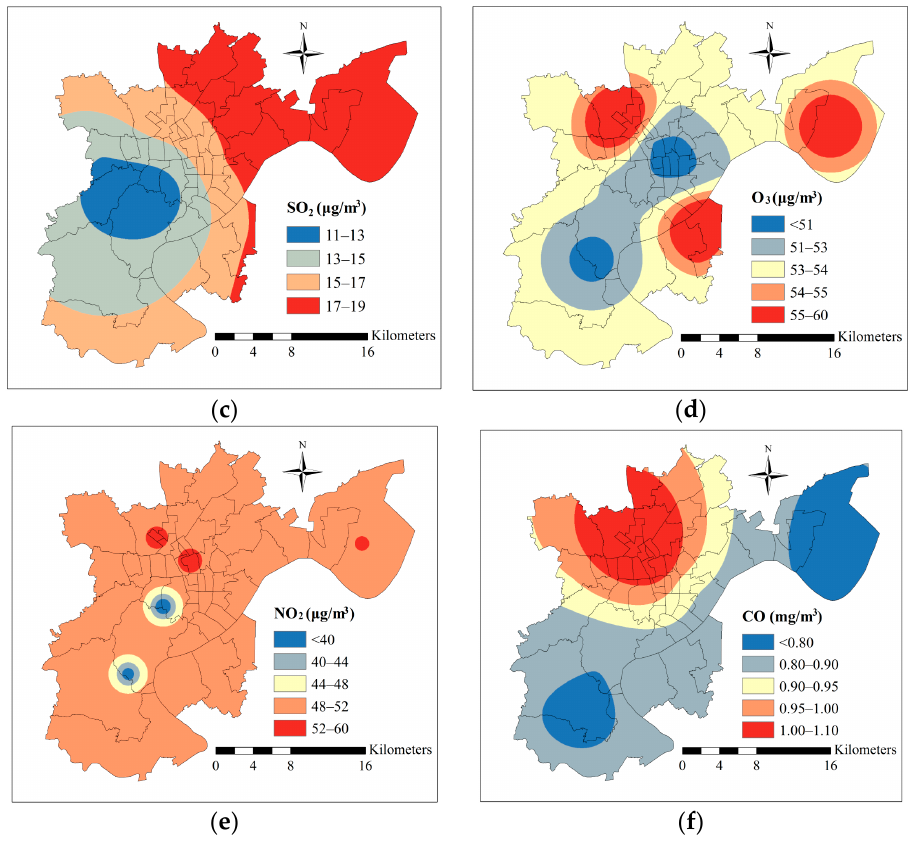
Figure 12. Spatial distribution of annual average concentrations of particulate matter and trace gases in Hangzhou City for 2015: ( a ) PM 2.5 ( μ g/m 3 ); ( b ) PM 10 ( μ g/m 3 ); ( c ) SO 2 ( μ g/m 3 ); ( d ) O 3 ( μ g/m 3 ); ( e ) NO 2 ( μ g/m 3 ); ( f ) CO (mg/m 3 ).